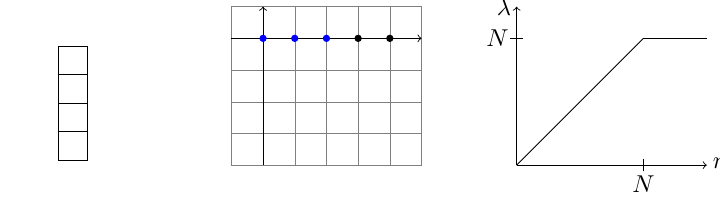
(d) The minimal puncture with G F = U(1) , correpsonding to the tableaux with one row of length 2 and N − 2 rows of length 1. Here, p ‘ = { 0 , 1 , . . . , 1 } .